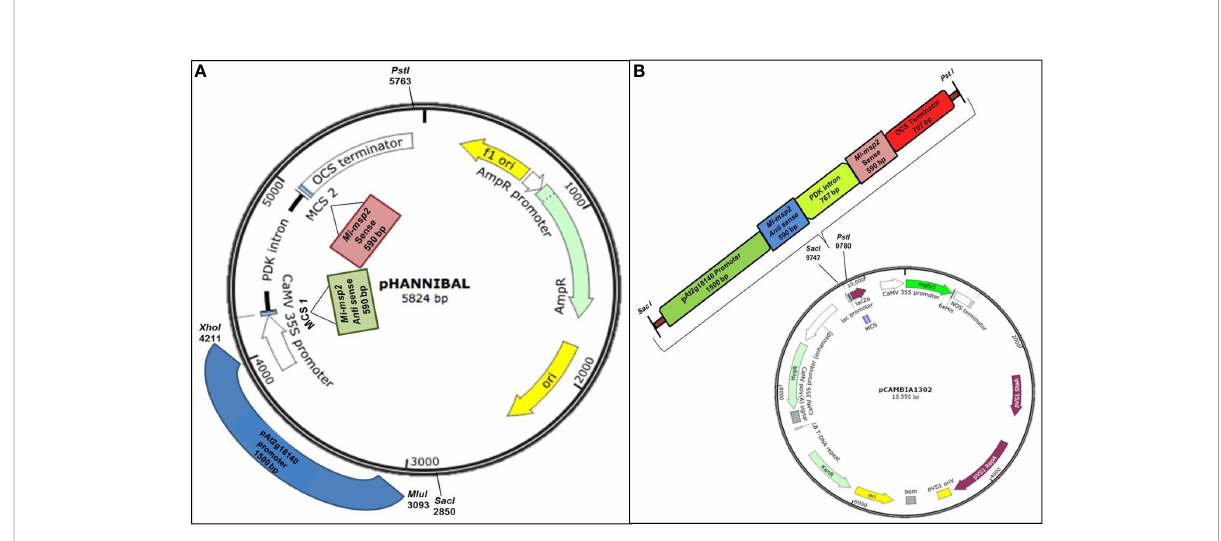
FIGURE 1 Constructs used in the study. (A) Cloning of the Mi-msp2 gene and promoter p At2g18140 in the RNAi vector p HANNIBAL . (B) Insertion of the RNAi cassette from p HANNIBAL into the binary vector p CAMBIA 1302 expressing the dsRNA construct for p At2g18140::Mi-msp2-RNAi